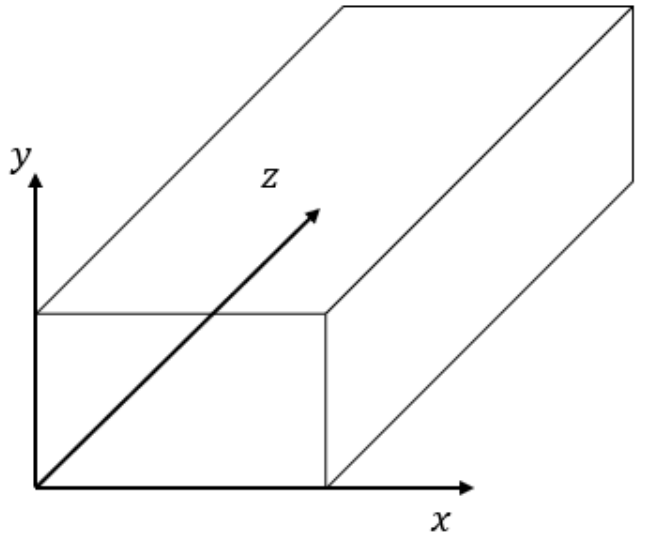
Figure 3. Coordinate system and cross-section of a rectangular channel.